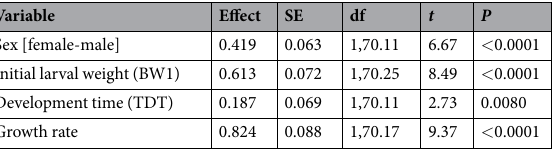
Table 1. Effects of sex, developmental time (DT), larval weight at hatching, and growth rate on the geometric mean of all adult body dimensions (GM; log10 transformed). All variables (other than sex) were standardised. Family was incorporated as a random variable.